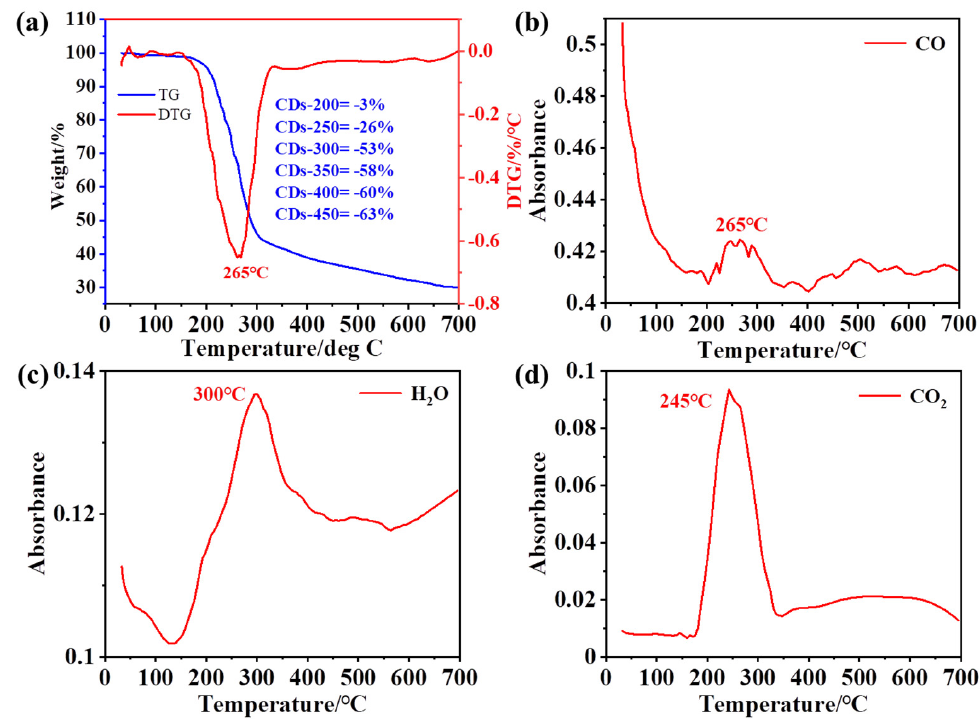
Figure 2. ( a ) TG/DTG curve of tannic acid. ( b – d ) The evolution of gaseous products for the components at 10 °C min − 1 .